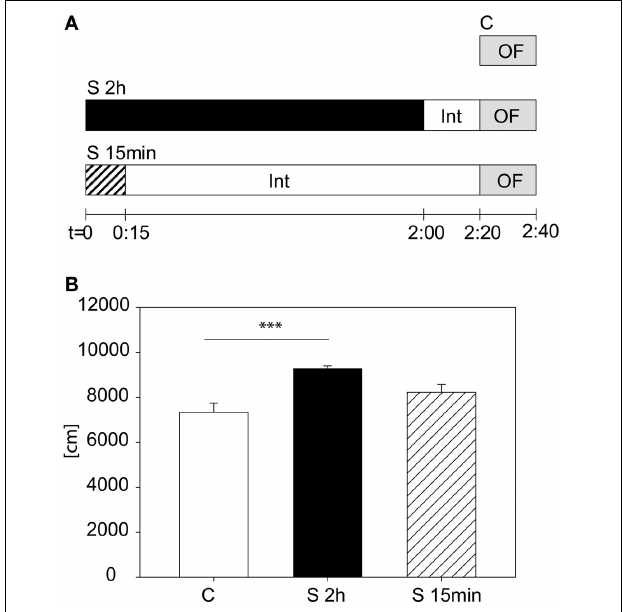
FIGURE 3 | Stress duration and interval between beginning of stress and beginning of the Open Field Test. Scheme of experimental design (A) . Distance traveled in the first 5min of the Open Field Test (B) . A significant difference was observed between the 2h stressed and control animals. Control group, C, in white, 2h stress group, S 2h, in black and 15min stress group, S 15min, in striped bars. Int, interval; Error-bars are shown as s.e.m.; Significances: ∗∗∗ p ≤ 0 . 001; n =